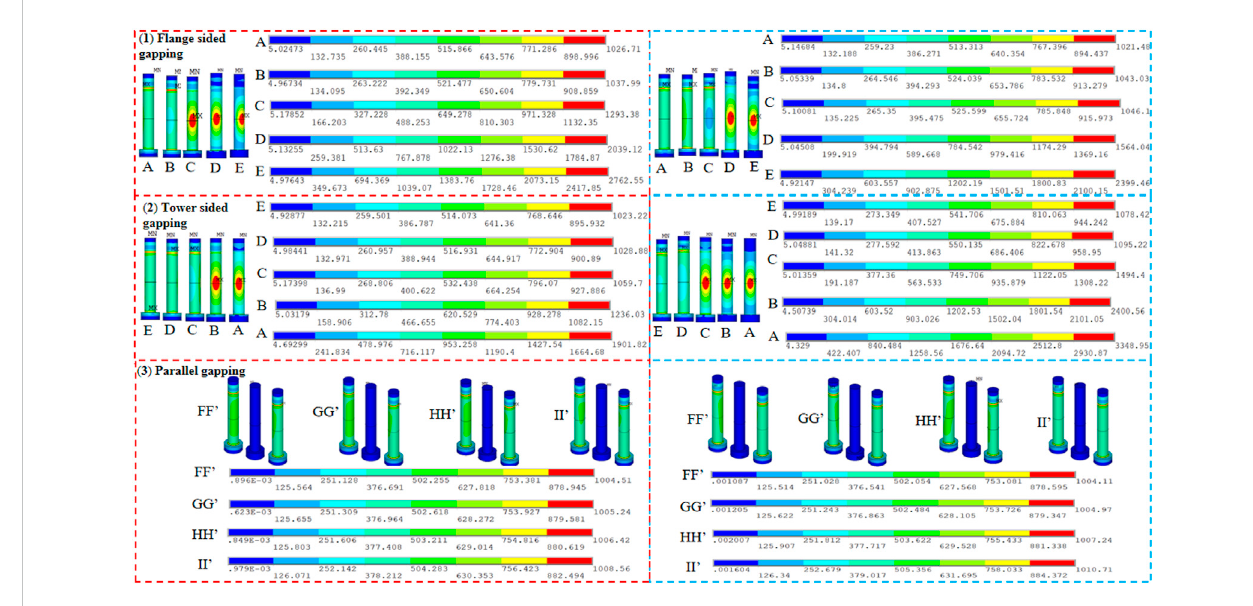
FIGURE 10 VonMisesstressstateoftheFOWTs ’ towerboltsundertheinitial fl atnessdivergencewhensubjectedtotensile(left)andcompressivestresses(right) (details of the location of openings are given in Figure 8).